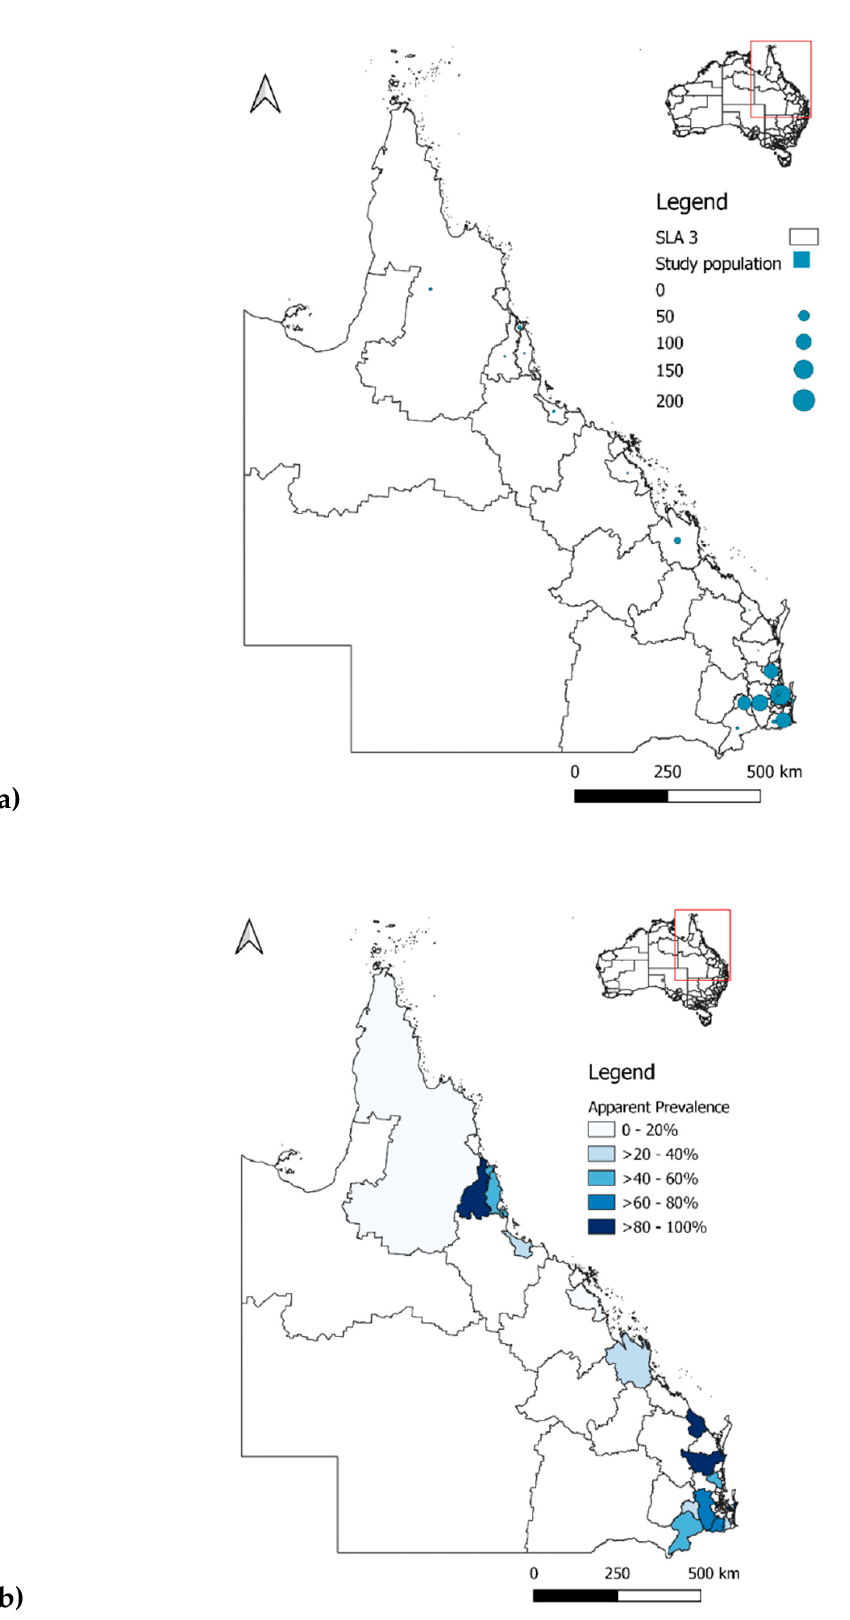
Figure 2. Maps of QLD classified by SLA 3 showing ( a ) distribution of sample population, and ( b ) apparent seroprevalence of